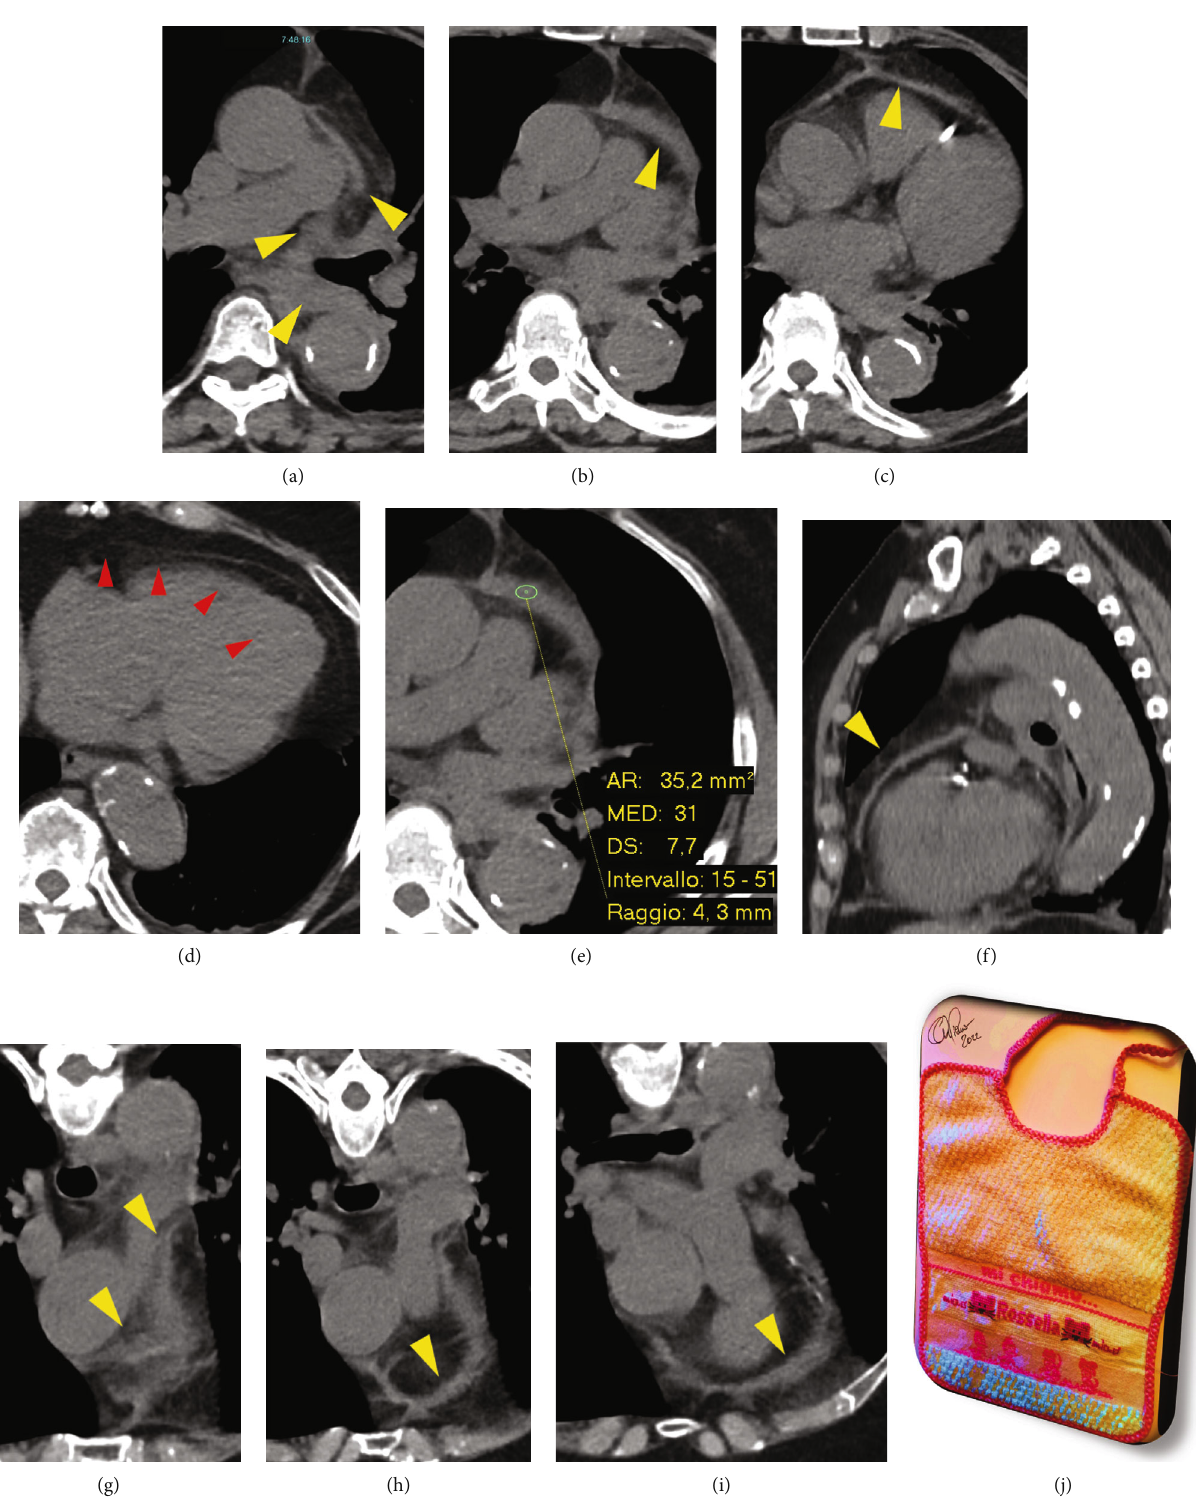
Figure 3: Unenhanced CT images showing the obliterated anterior descending aortic and paraesophageal fat due to hyperattenuating fl uid collection (red arrowhead in (a)). The fl uid fl owed anteriorly through the extrapericardial inlet, under the left branch of the pulmonary artery, and above the left pericardial pulmonic recess of transverse sinus (green arrowhead in (a)). The fl uid reached the anterior surface of the pericardial sac, between the prevascular and visceral mediastinal compartments (yellow arrowheads in (a – c) and (g – i)), and then fl owed out caudally, covering the anterior wall of the right ventricle (yellow arrowheads in (f)), as a sort of “ bib ” on the heart (j). No associated pericardial e ff usion (red arrowheads in (d)). High-attenuation extrapericardial fl uid (average 31 HU) consistent with hemomediastinum